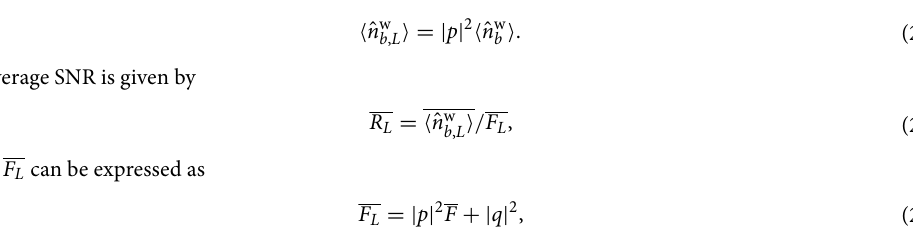
2 sinh 2 g indicates the corresponding total α | | +